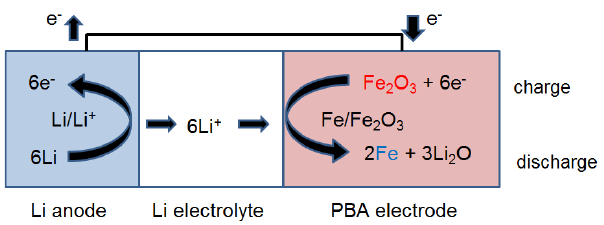
Figure 5. Schematic illustration for the reversible low voltage charge/discharge process. PBA: Prussian blue